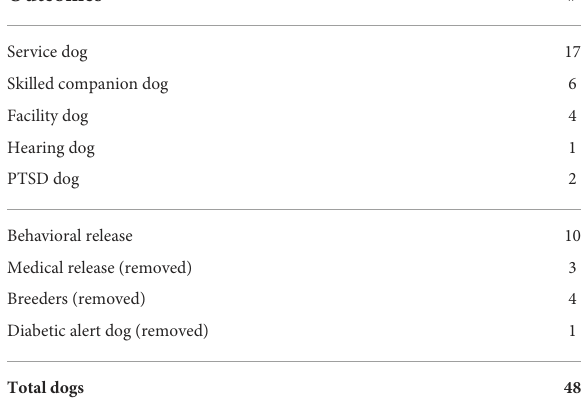
TABLE 1 Demographics and outcomes of the service